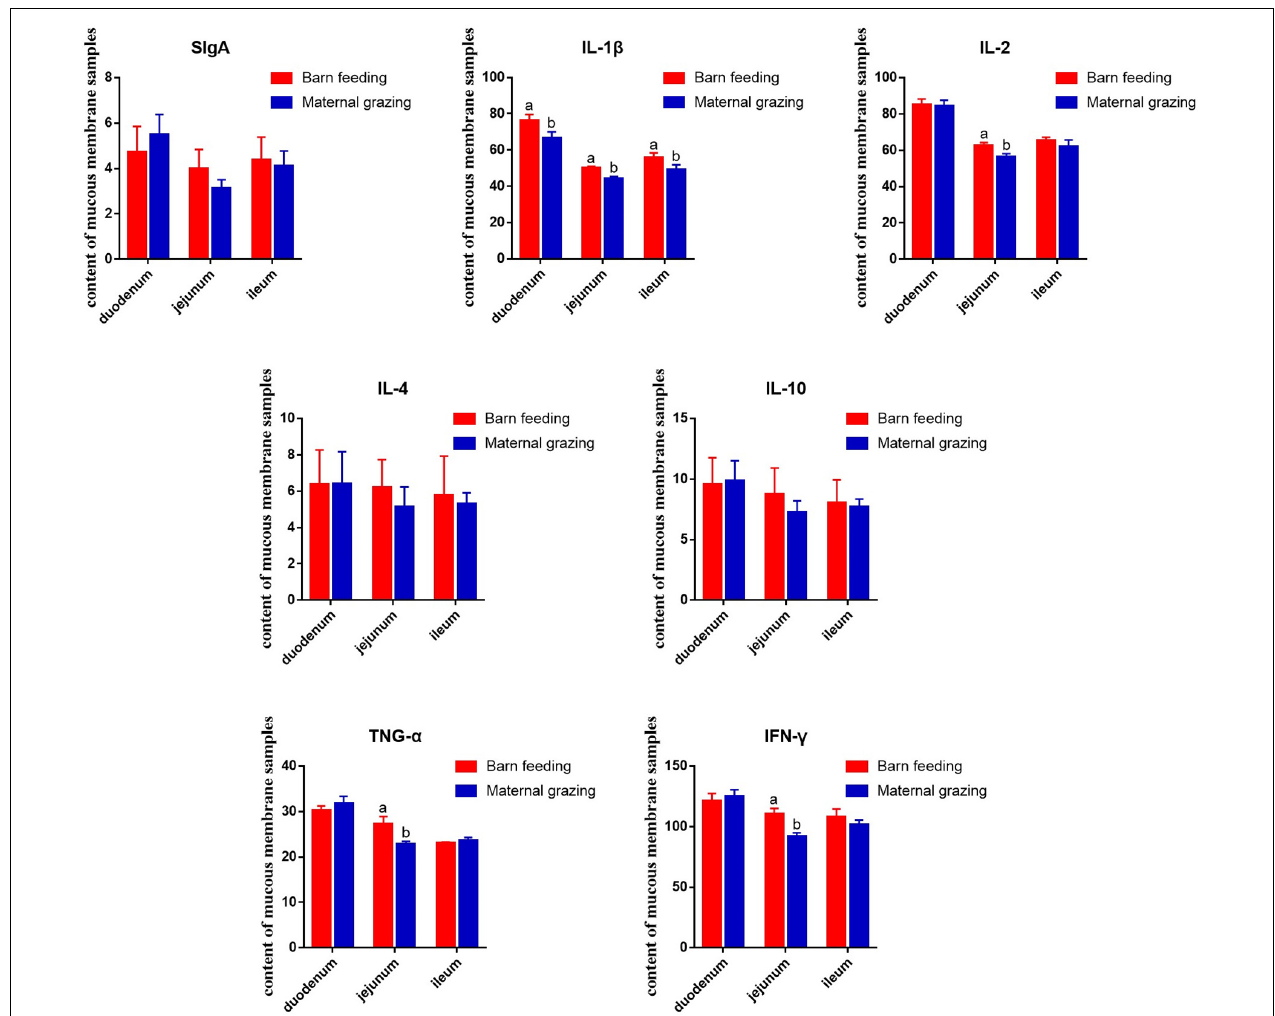
FIGURE 2 | Effect of two different feeding strategies (maternal grazing and barn feeding) during early life on the sIgA and immune cell cytokine content of mucous membrane samples from the duodenum, jejunum, and ileum of yak